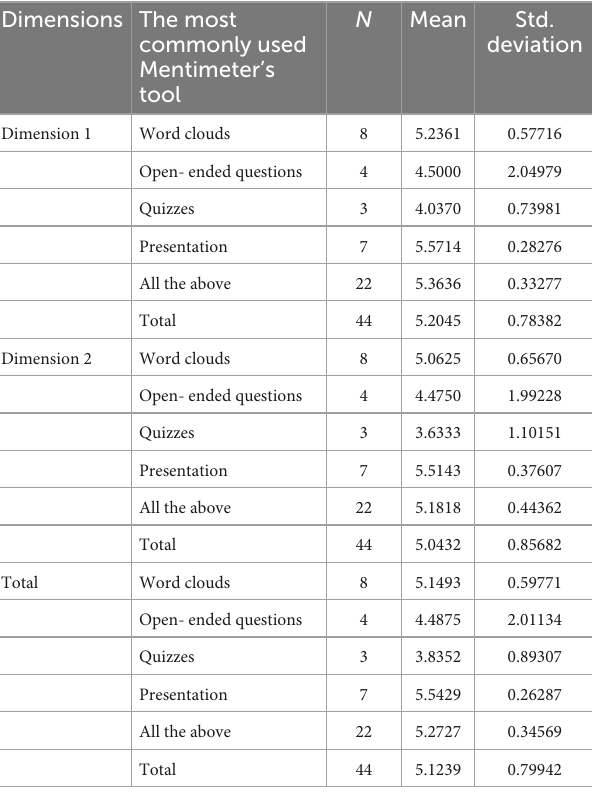
TABLE 13 Results of one-way ANOVA (based on most commonly used Mentimeter’s tool).